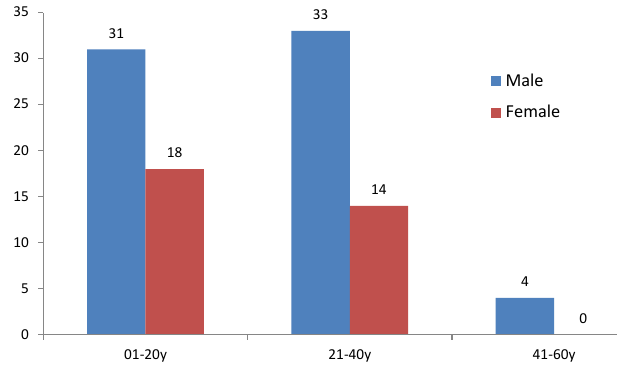
Figure 1. Clinicodemographic Profile of Patients Suffering From Typhoid